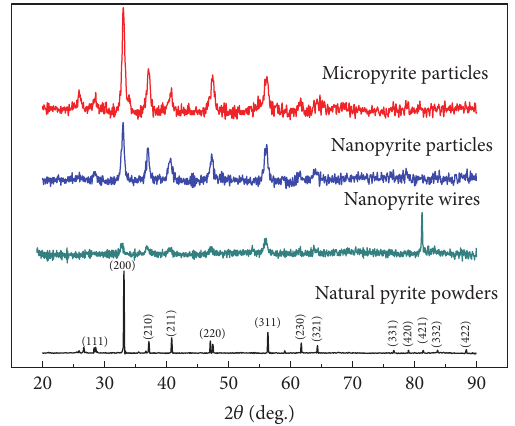
Figure 1: XRD patterns of different pyrite samples.